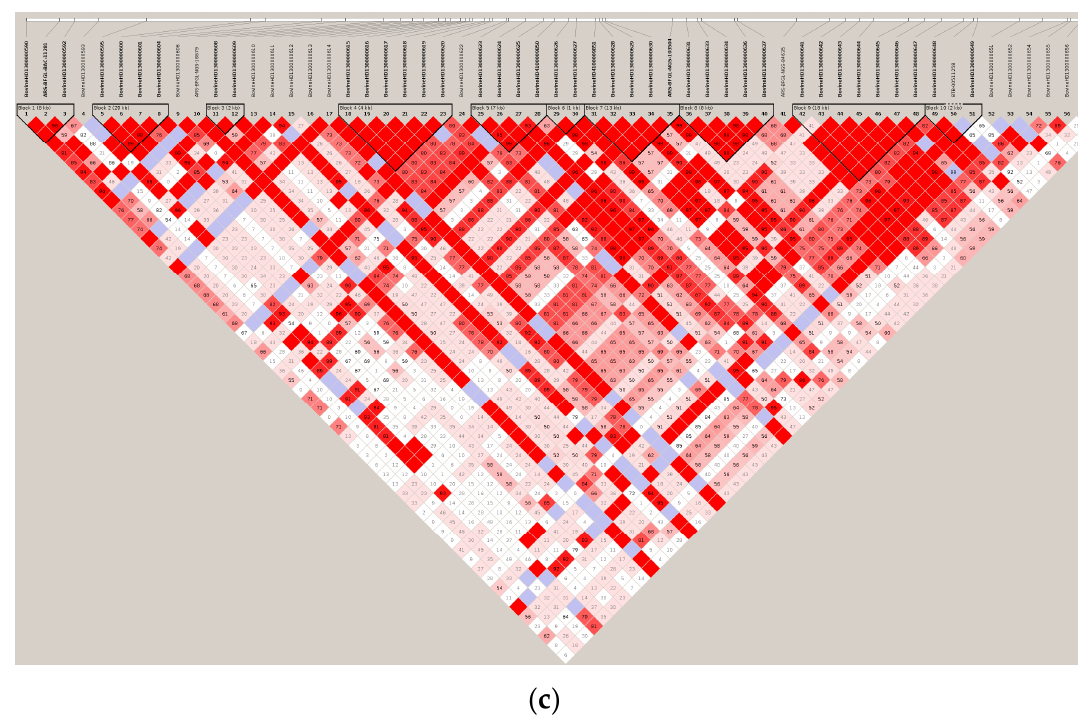
Figure 4. Haplotype structures viewed using Haploview for carcass traits. ( a ) Top haploblock on BTA13 with p -value of 5.27 × 10 − 6 , from nsnp5 method which included PLCB1 gene, ( b ) top haplotype block from LD 0.2 method on BTA11 with p -value of 5.16 × 10 − 6 , which included the CEL gene, and ( c ) top haplotype block from Len200 method on BTA13 with p -value of 3.02 × 10 − 6 which included the PCLB4 gene.